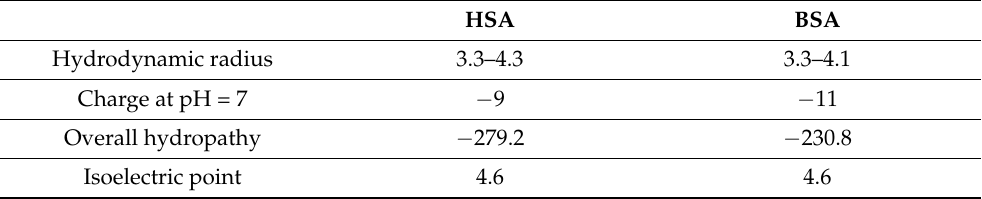
Table 2. Comparison of HSA vs. BSA (adopted from [12,29,58]).